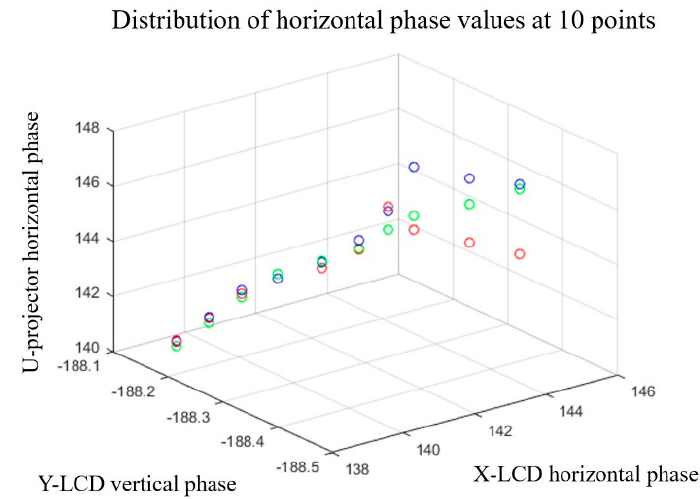
matic aberration diagram of the blue-green channel is shown in Figure 12. The length and